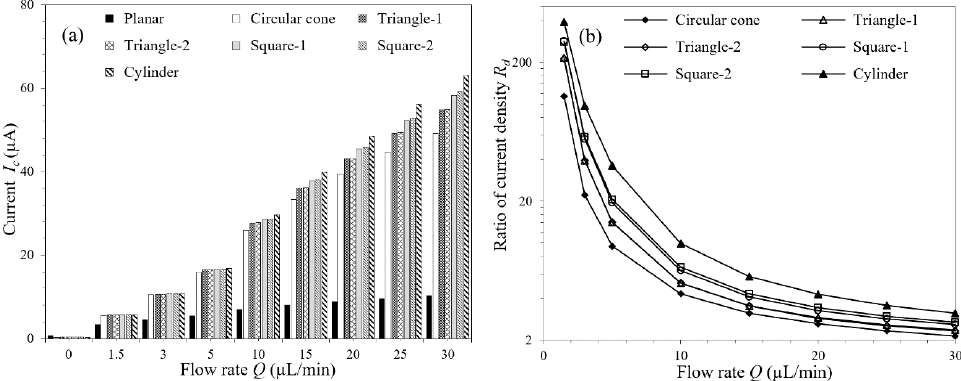
Figure 8. ( a ) Current responses of the planar electrode and the μ AEs with micropillars in different shapes under varying flow rates; ( b ) The current density ration of the μ AEs with micropillars in different shapes under varying flow rates.